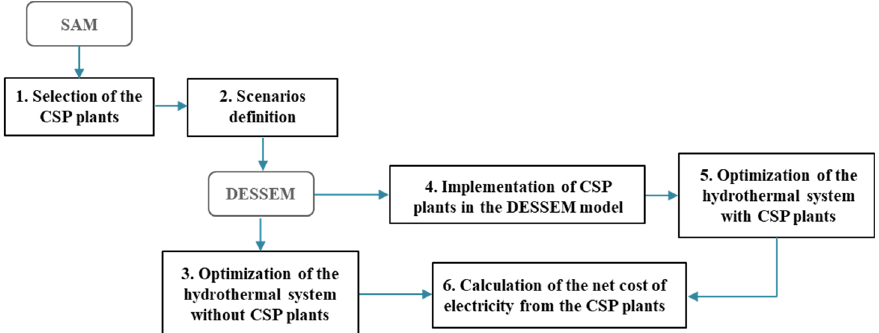
Figure 1. Methodological steps used in the case study.